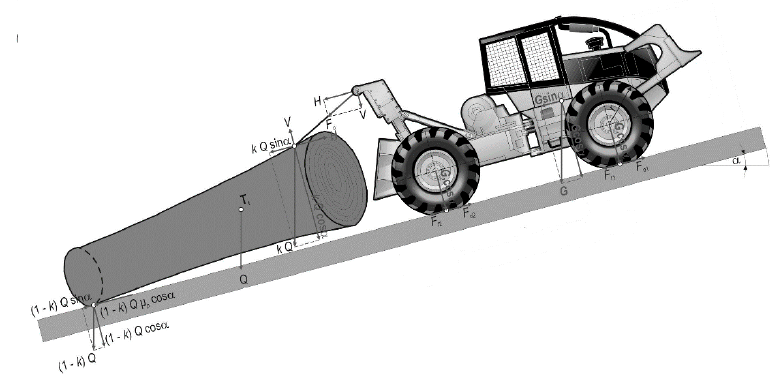
Figure 2. Forces acting upon the skidder and load during skidding [20].